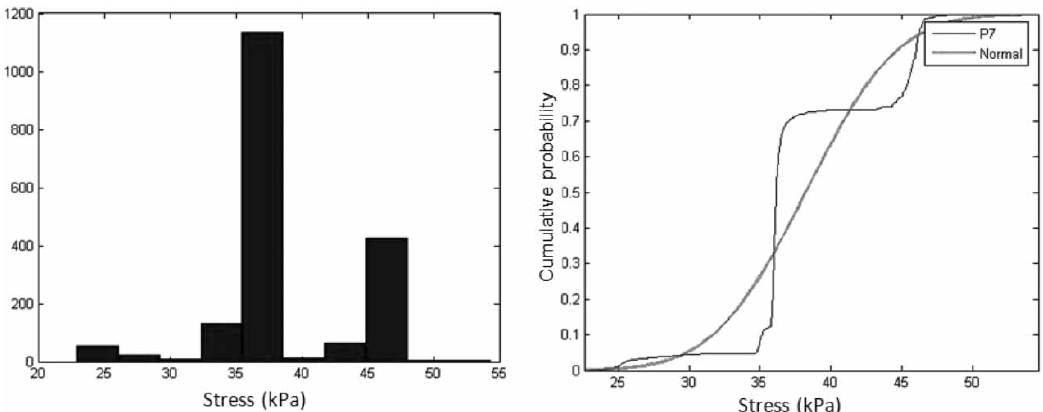
Fig. 6. Histogram and CDF of pore pressure in horizontal drain